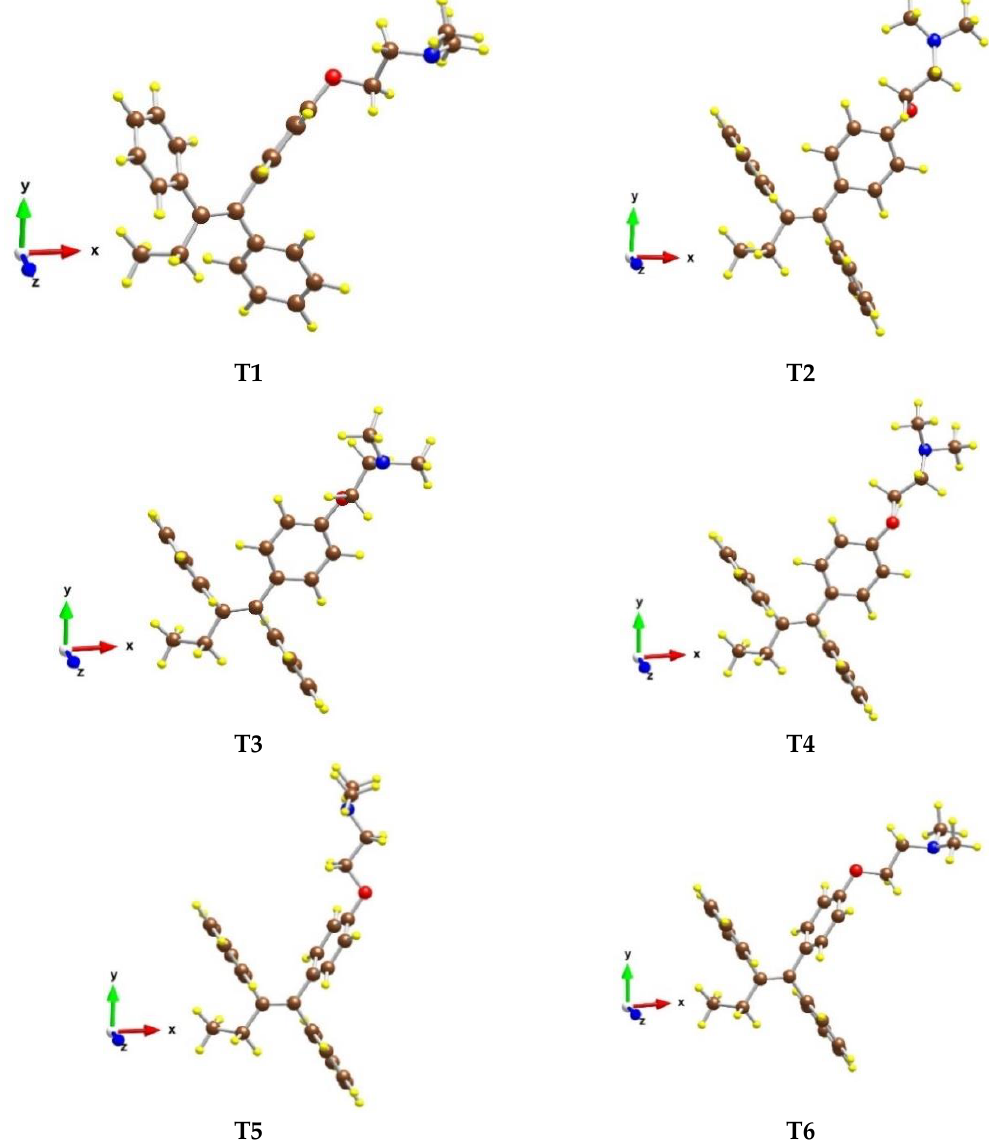
Figure 4. Optimized structures of different conformers of the tamoxifen molecule in gas phase. Color coding: C — brown, O — red, N — blue, and H — yellow.